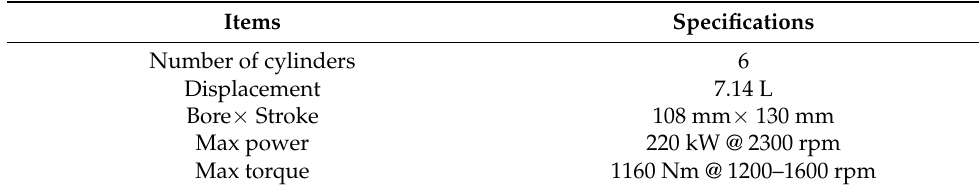
Table 2. Details of working modes.